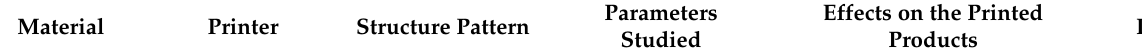
Parameters Effects on the Printed Studied